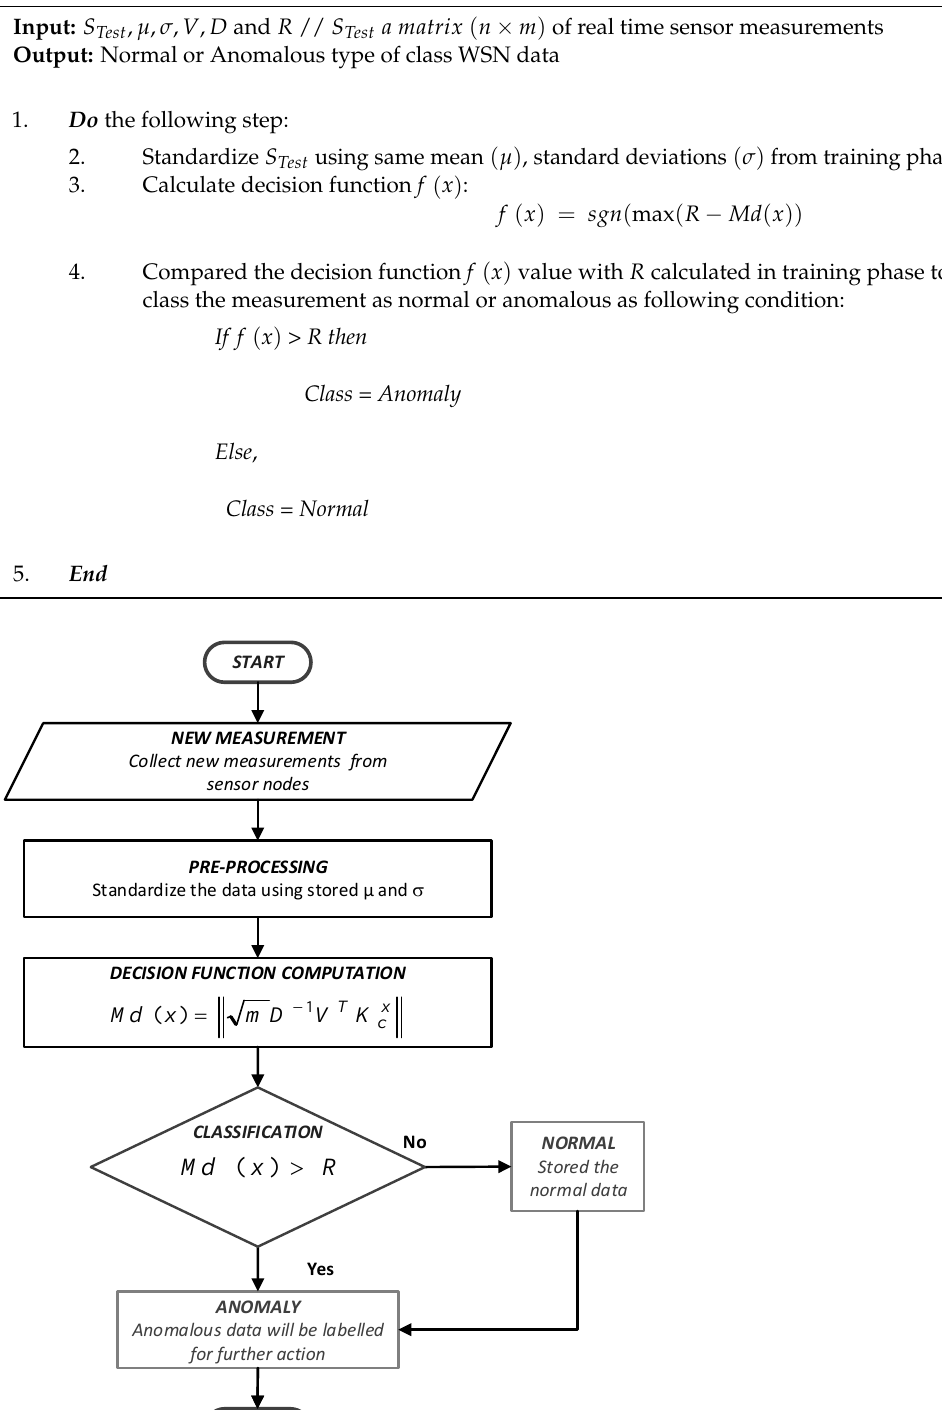
Algorithm 2: Pseudocode algorithm for the detection phase of proposed CESVM-DR Scheme